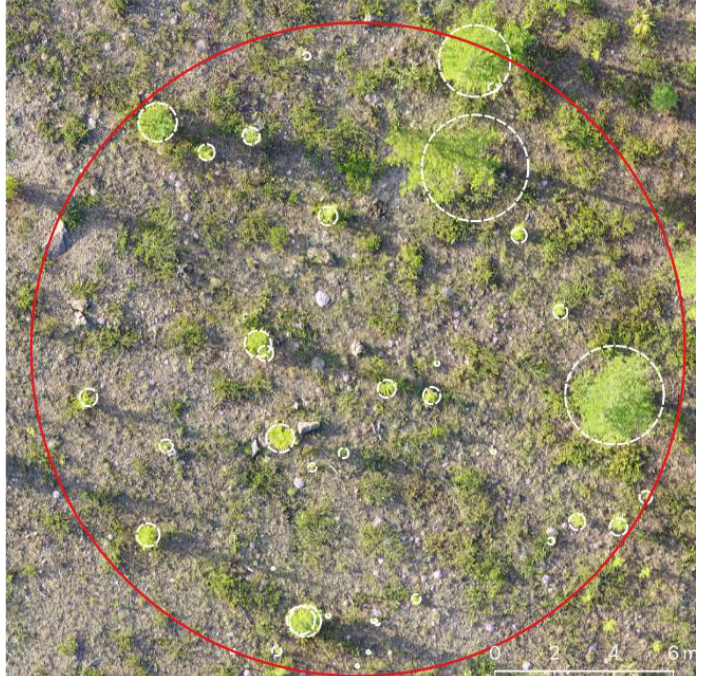
Figure 2. Fragment of image mosaics obtained using drone images, with superimposed polygonal layer of Siberian larch crowns, calculated using land-based measurements of orthogonal crown projections (white dash lines). The red line marks the boundary of a sample plot.